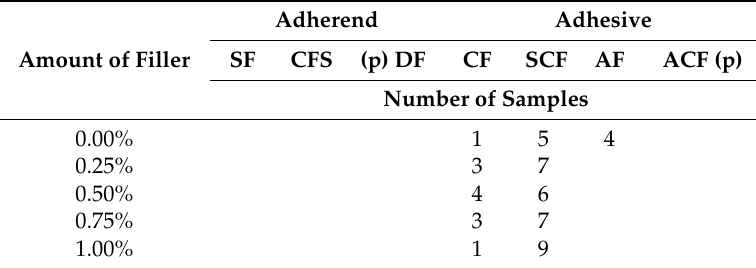
Table 6. Failure patterns evaluation according to EN ISO 10365 Standard—method II.